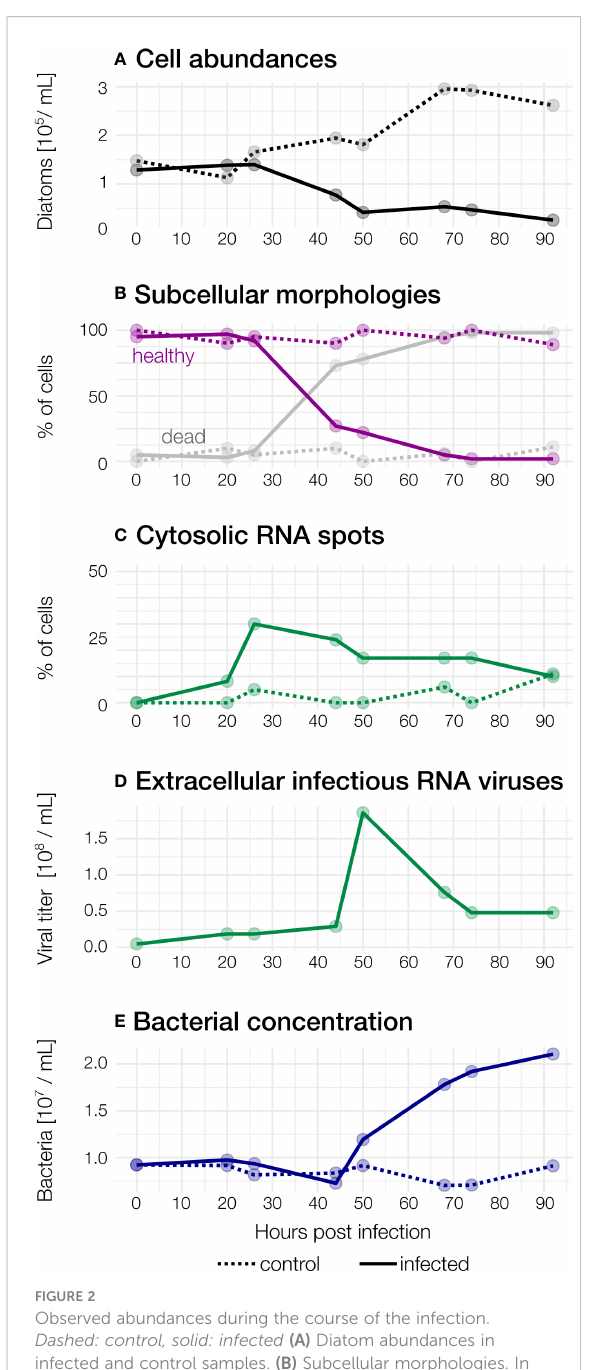
FIGURE 2 Observed abundances during the course of the infection. Dashed: control, solid: infected (A) Diatom abundances in infected and control samples. (B) Subcellular morphologies. In infected samples, the proportion of “ healthy ” diatoms declines rapidly after 26hpi, but not in control samples. Cells were counted as “ dead ’’ when they showed a broken frustule, no nucleus and/or were heavily colonised by bacteria. (C) Cytosolic RNA spots. (D) Concentration of infectious extracellular RNA viruses. (E) Bacterial concentrations increase from 50 hpi in the infected